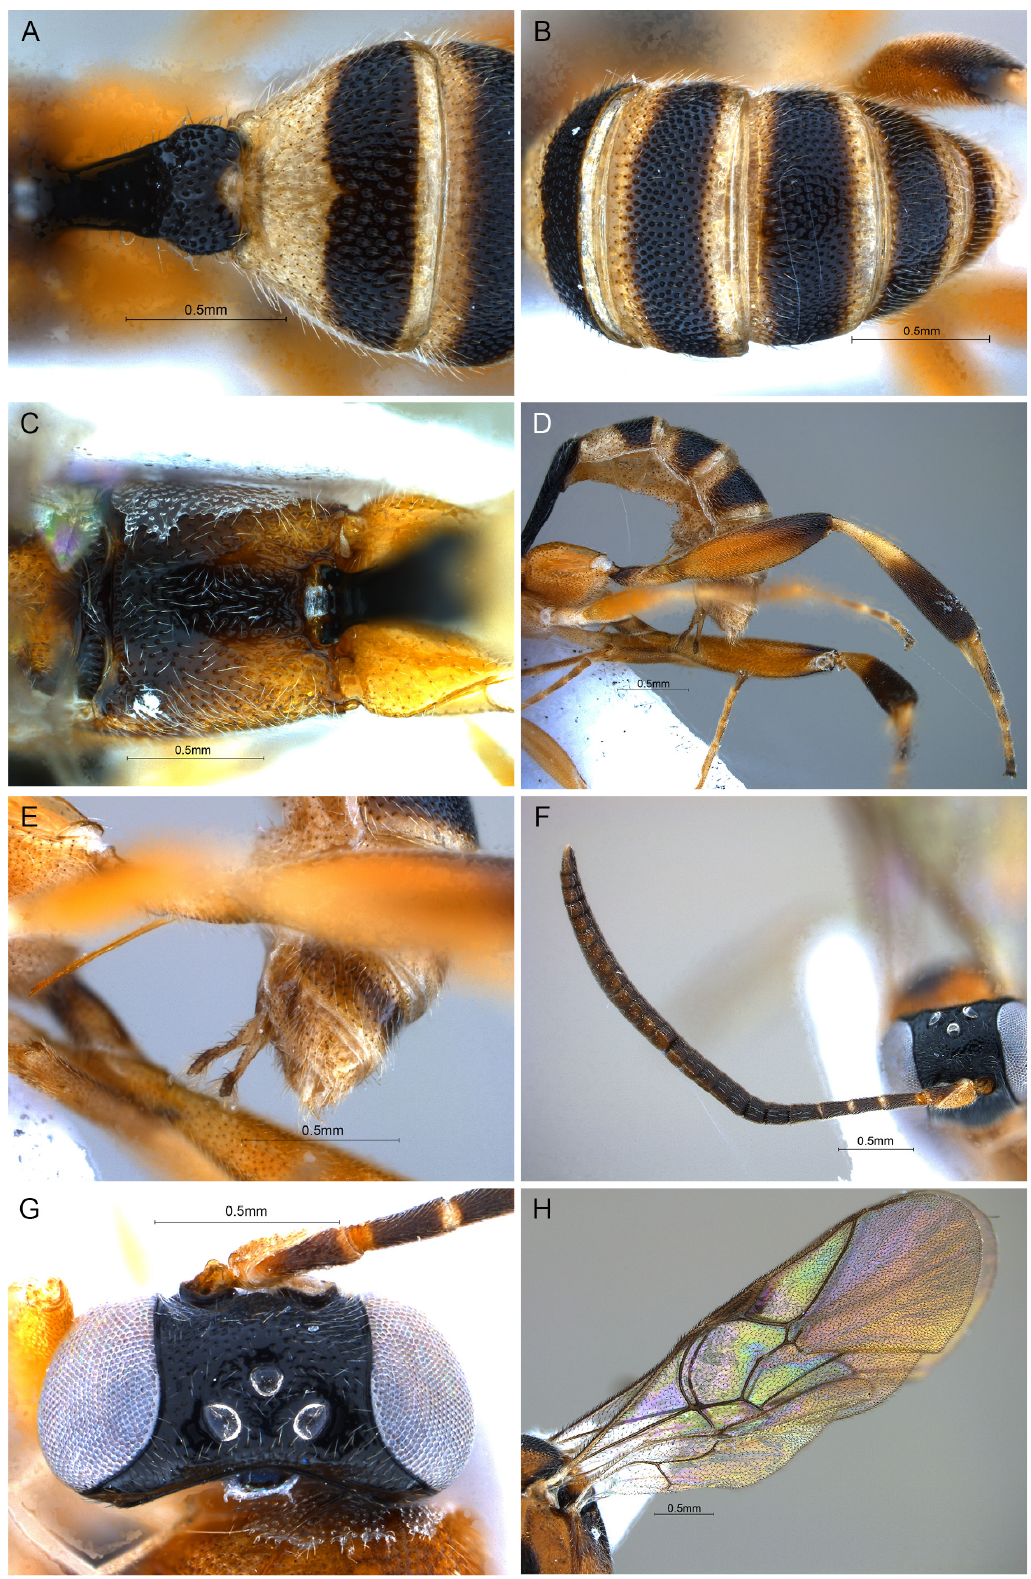
Fig. 6. Palpostilpnus aki sp. nov., holotype, ♀ (KIZ). A . T1 and T2, dorsal view. B . T3–T5, dorsal view. C . Propodeum, dorsal view. D . Hind leg. E . Ovipositor. F . Antenna. G . Vertex. H .